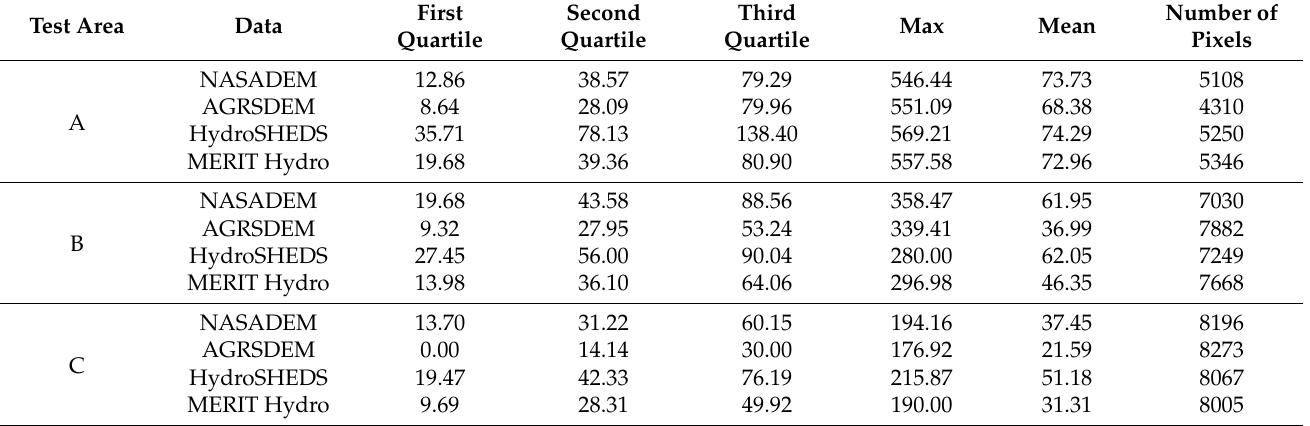
Table 1. The statistical value of offset distance of the river network extraction results was produced using different rebuild DEMs in the test area A, B and C.